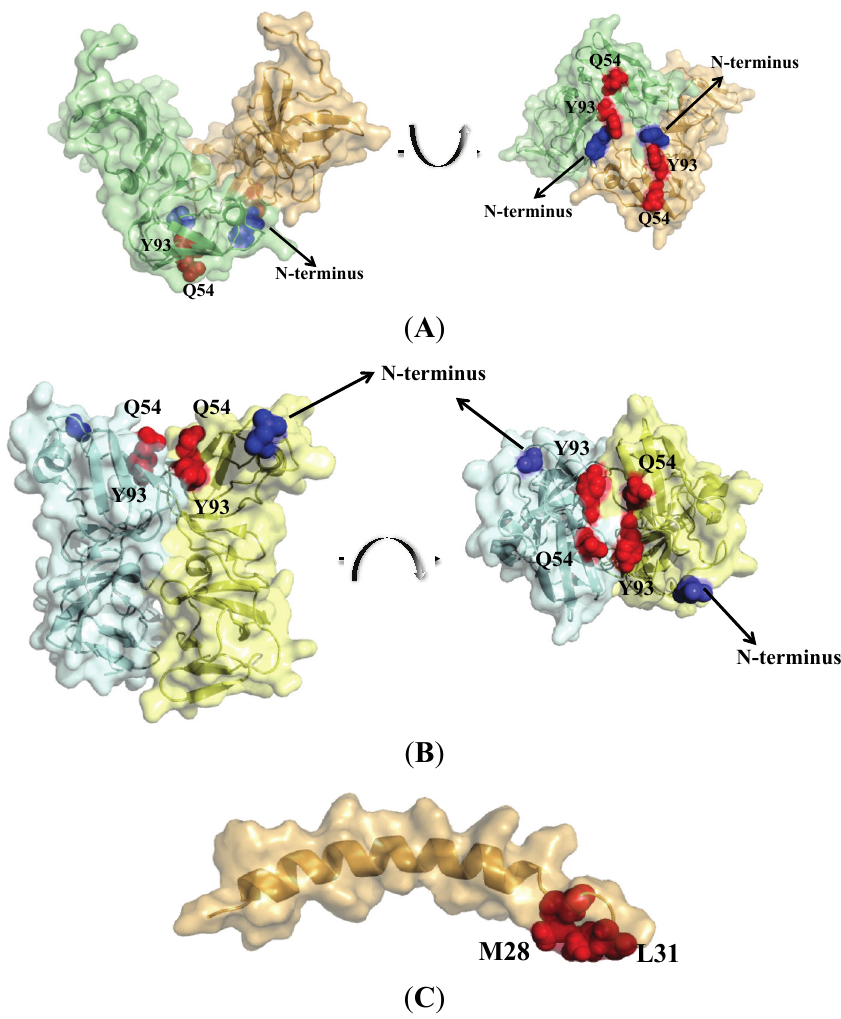
Figure 3. Structures of NS5A domain I. Amino acid positions associated with resistance to DCV are shown as red spheres. The N-terminal amino acid in each monomer is shown in blue. ( A ) Front view and a 90° in plane rotation of the “open” conformation of NS5A (36–198) (PDB 1ZH1); ( B ) The side view and an out-of-plane rotation of the “closed” conformation of NS5A (32–191) (PDB 3FQQ); ( C ) The structure of the N-terminal amphipathic helix of NS5A (1–31) (PDB 1R7G). It is expected to link with each monomeric structure at the N-terminal amino